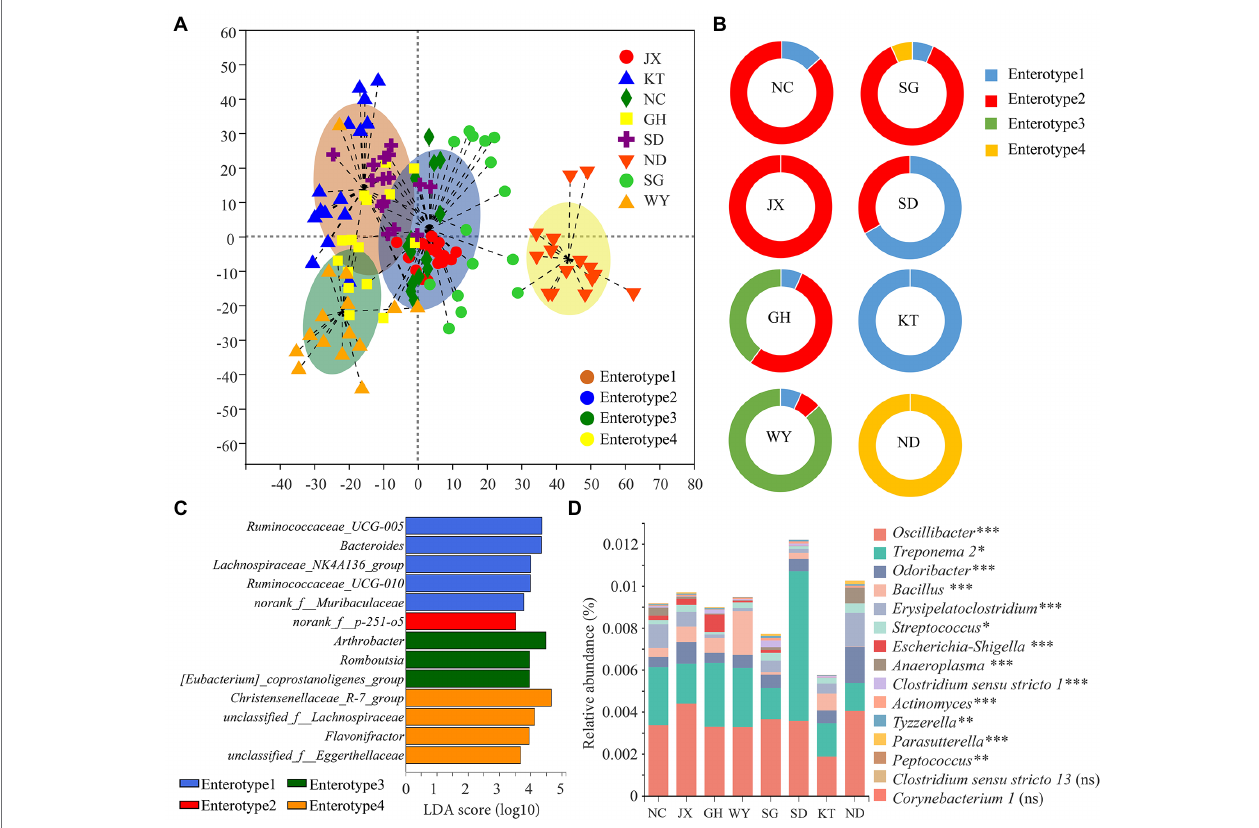
FIGURE 7 | Analysis of the enterotype and the pathogenic bacteria of Przewalski’s gazelle from the different study areas. (A) Analysis of the diagram of the enterotype. (B) Analysis of the enterotype distribution of Przewalski’s gazelle in the different study areas. (C) Marker bacteria of each enterotype. (D) Analysis of the differences between the groups of the potentially pathogenic bacteria. * p < 0.05; ** p < 0.01; and *** p < 0.001. ns, no